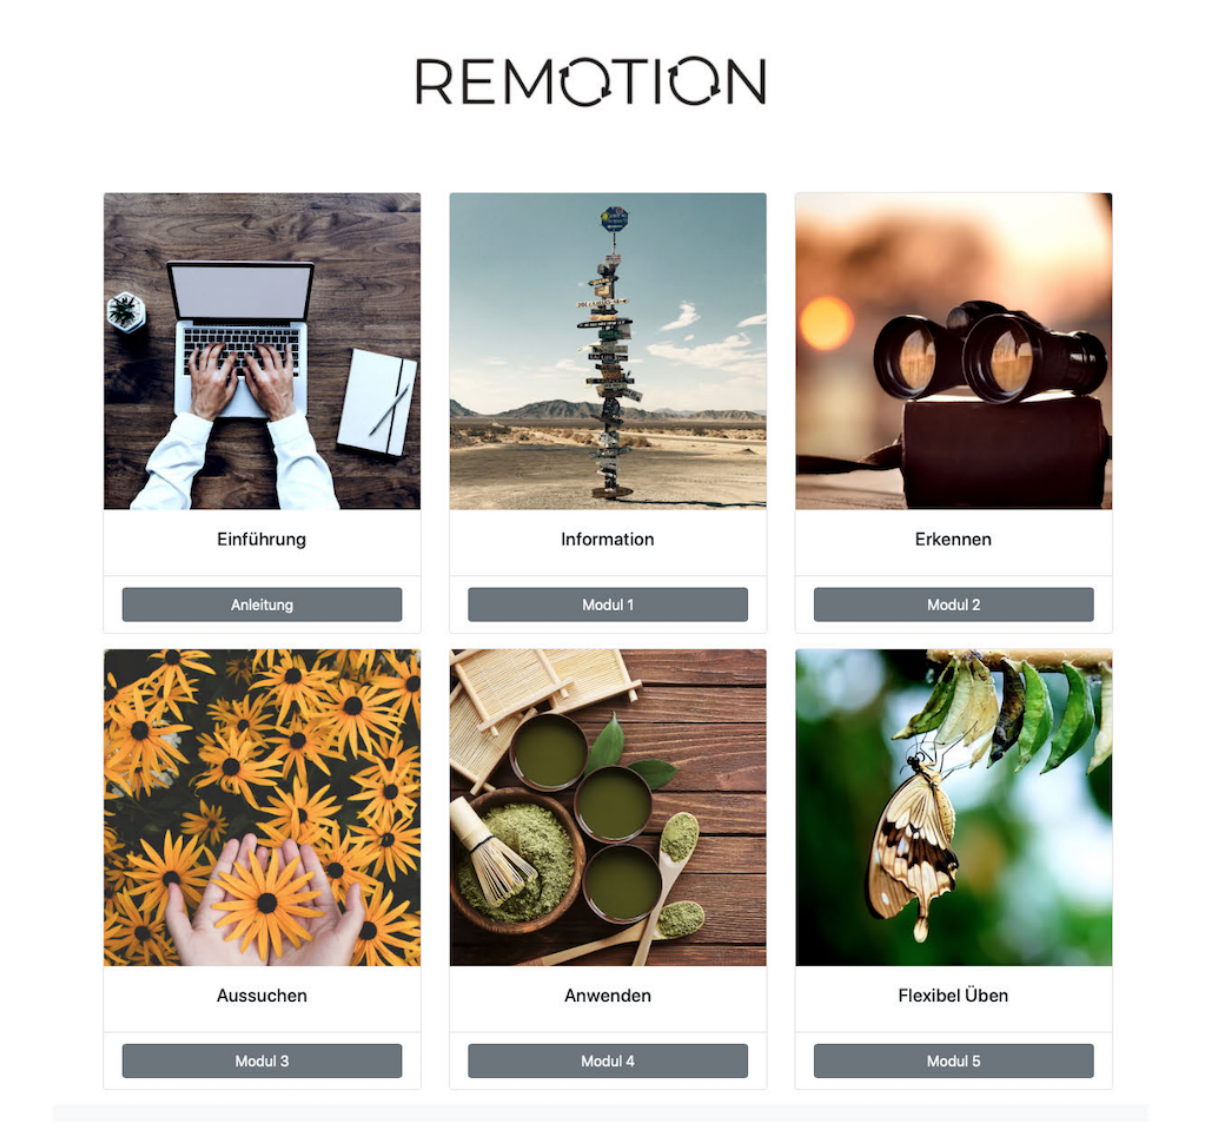
Figure 2. REMOTION homepage.